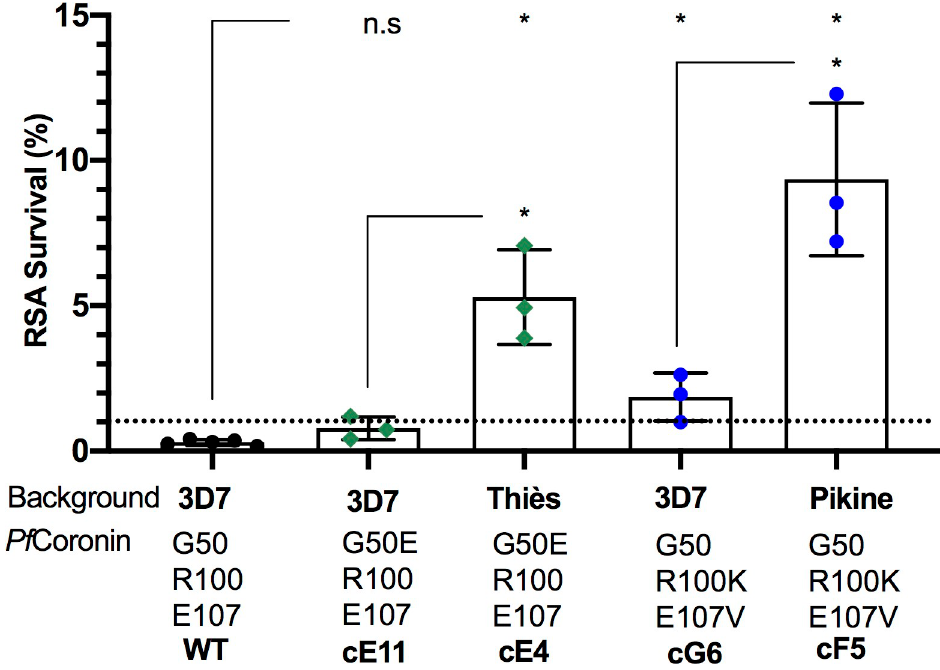
Fig 2. The level of resistance conferred by mutant pfcoronin is background dependent. Ring-stage survival assay (RSA) survival percentage of pfcoronin mutants in 3D7 background with either G50E (clone E11, green) or R100K and E107V (clone G6, blue) compared to wildtype (WT) 3D7 (black), and previously published [17] survival values for one of the clones of pfcoronin CRISPR mutants in the Thi è s (clone E4, green) and the Pikine (clone F5, blue) backgrounds. Each data point represents an independent biological replicate and the dotted line represents the 1% survival threshold, above which survival is considered resistant. Significance level is indicated by the asterisks, � p < 0.05, determined using an unpaired two-tailed student t-test with Welch’s